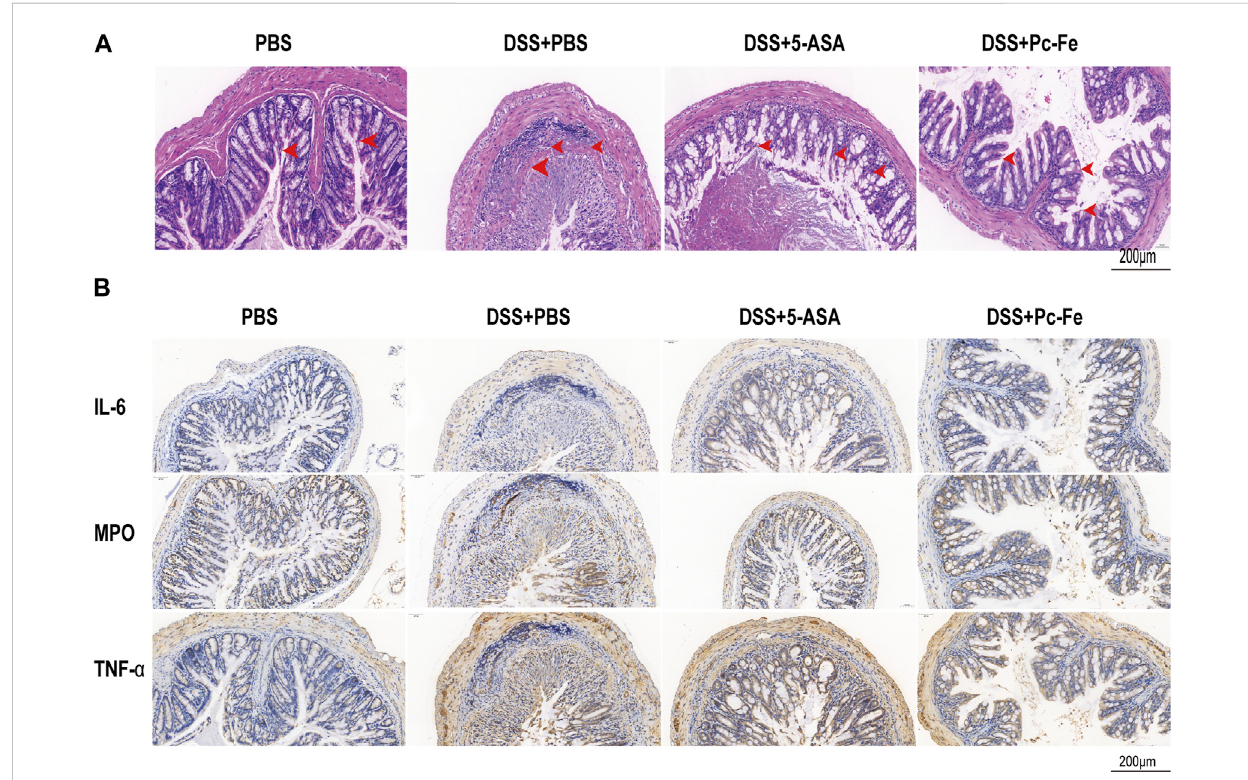
FIGURE 6 Histopathological examination of Pc-Fe. (A) Representative image of colon tissue stained with H&E from each group. (B) Immuno fl uorescence staining image of mice. Sections of tissue were stained with IL-6 and MPO and TNF- α from each group.